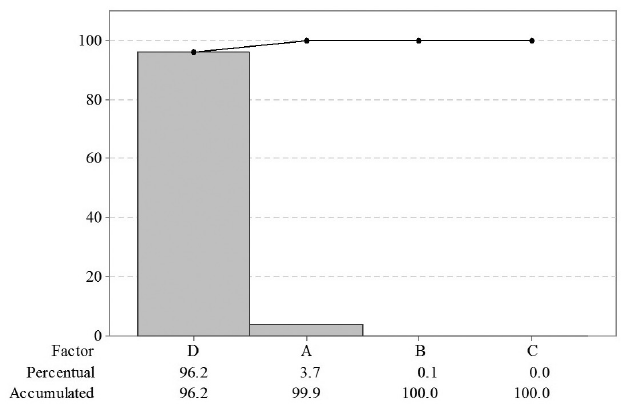
FIGURE 7 - Pareto chart of the contribution of time of dissolution (A), volume of dissolution media (B), pH of dissolution media (C), and rotation speed (D) to overall